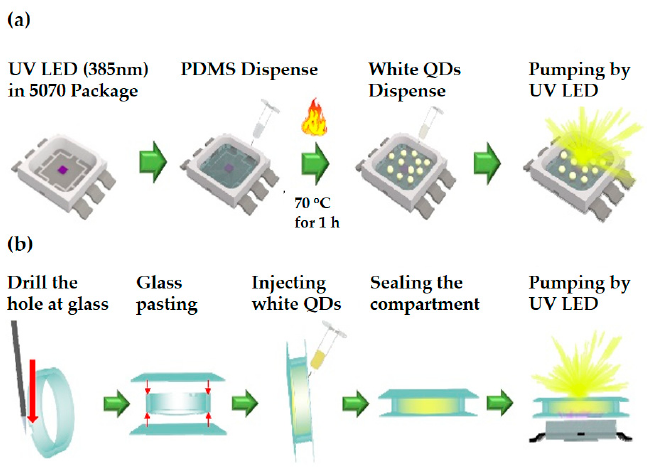
Figure 1. Schematic diagram of ( a ) RWQD-WLED and ( b )